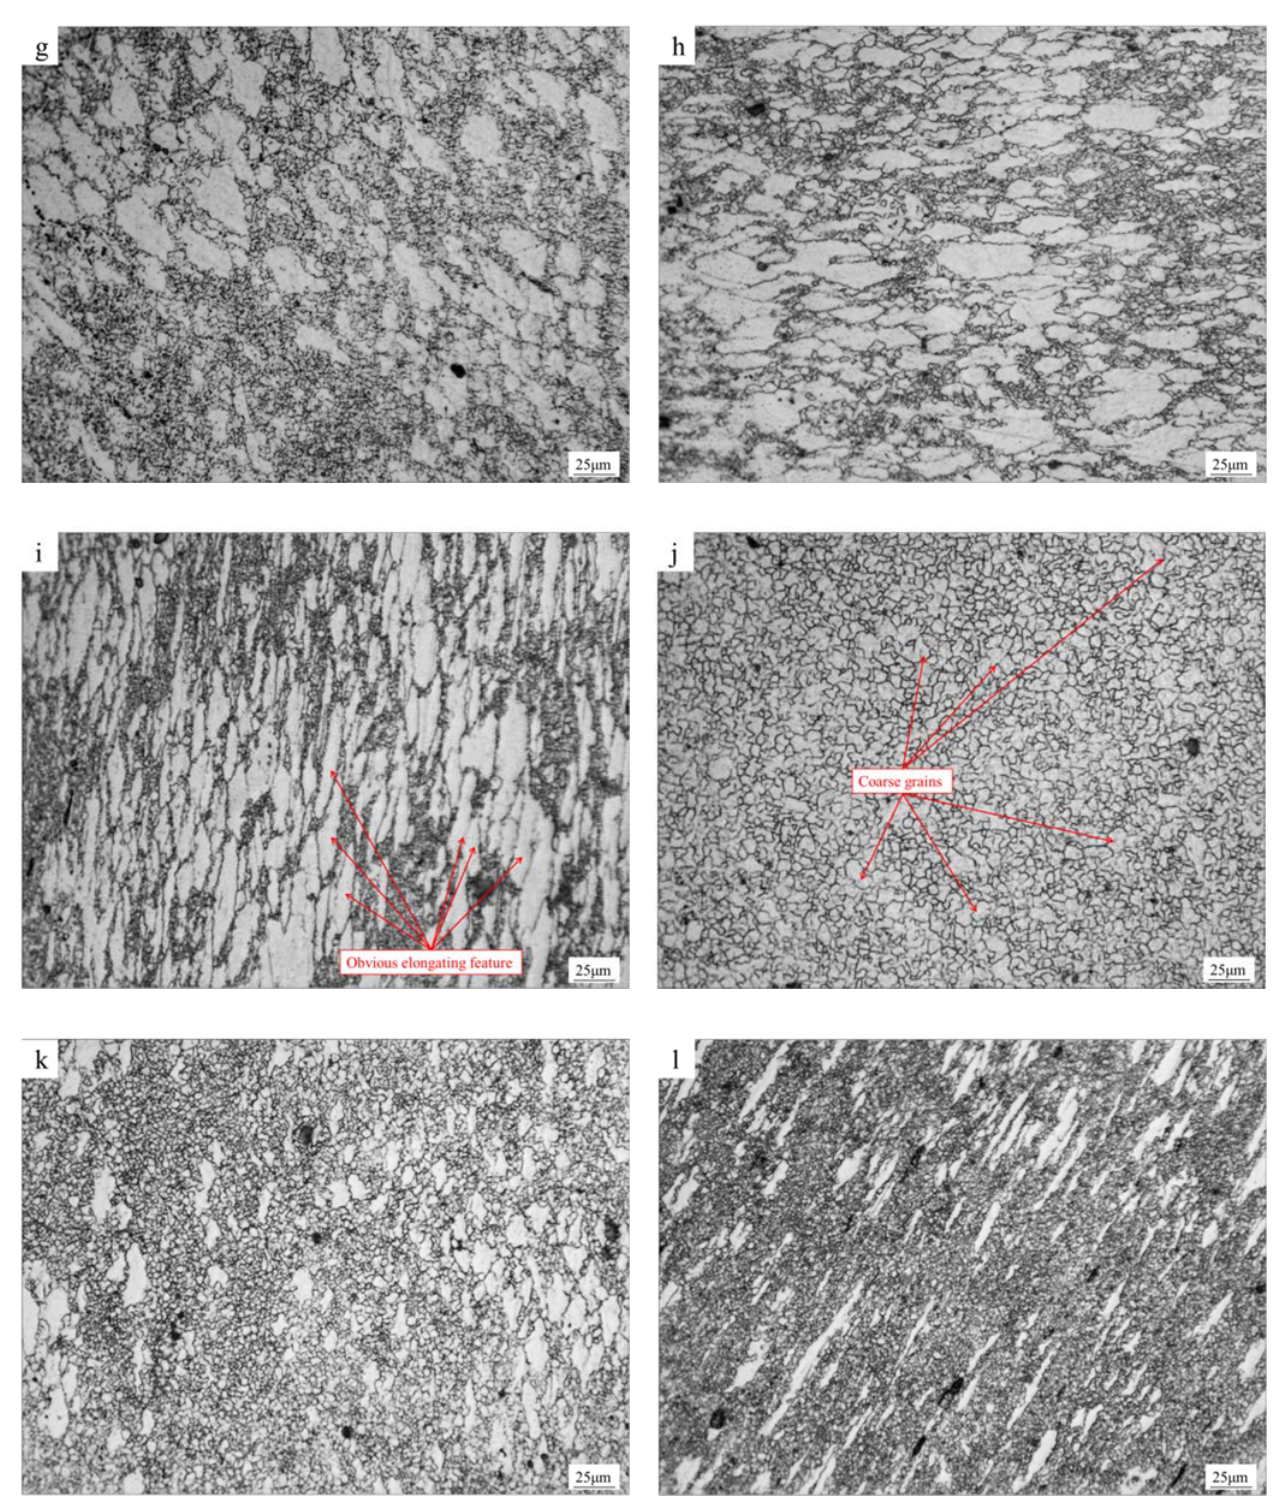
Figure 9. The metallography of AZ31B at different temperatures and strain rates. ( a ) 0.017 s − 1 at 25 °C; ( b ) 0.17 s − 1 at 25 °C; ( c ) 0.34 s − 1 at 25 °C; ( d ) 0.017 s − 1 at 150 °C; ( e ) 0.17 s − 1 at 150 °C; ( f ) 0.34 s − 1 at 150 °C; ( g ) 0.017 s − 1 at 200 °C; ( h ) 0.17 s − 1 at 200 °C; ( i ) 0.34 s − 1 at 200 °C; ( j ) 0.017 s − 1 at 250 °C; ( k ) 0.17 s − 1 at 250 °C; ( l ) 0.34 s − 1 at 250 °C. With the increase in temperature, the deformation degree of grains was gradually increased, and the grains were elongated in the tensile direction, as shown in Figure